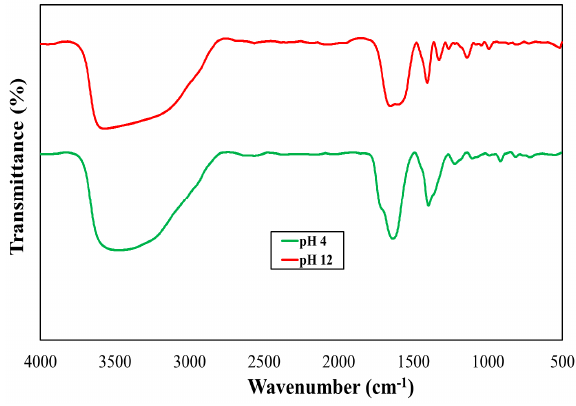
Figure 9. Fourier Transform Infrared Spectroscopy (FTIR) analysis of GLDA at different pH.